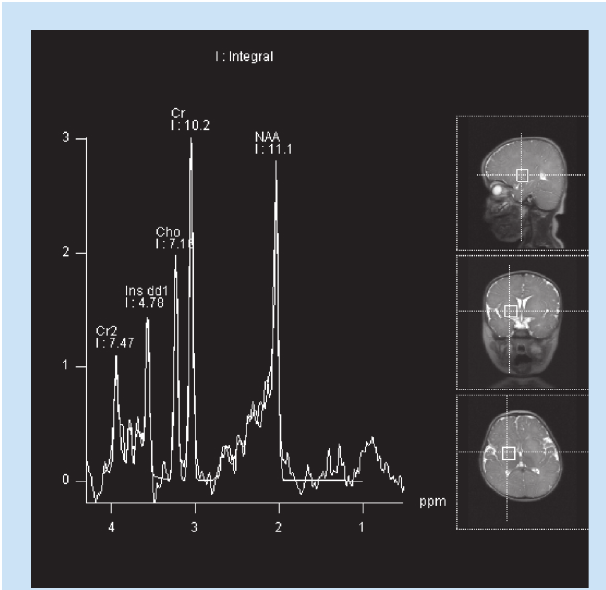
Fig. 4. Magnetic resonance spectroscopy data: single voxel STEAM acquisition (TR/TE = 3 000/20 ms) of the right lentiform nucleus, demonstrating unusual peak configuration near 2.07